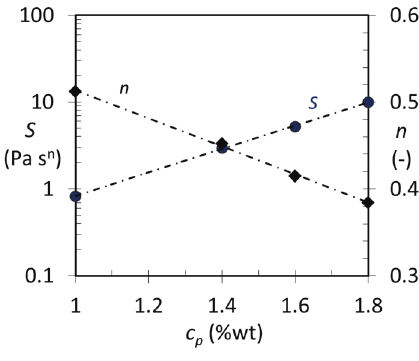
Fig. 8 – Concentration dependence of scaling exponent n (diamonds) and gel strength S (circles)